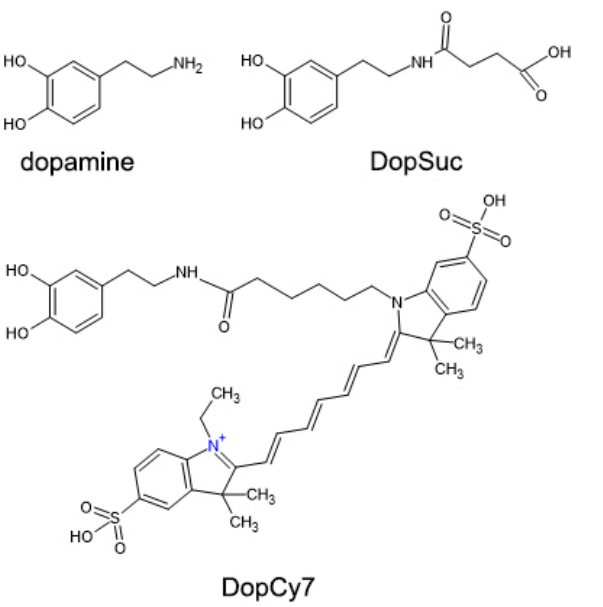
Figure 2. Structures of dopamine and dopamine derivatives used in this study.